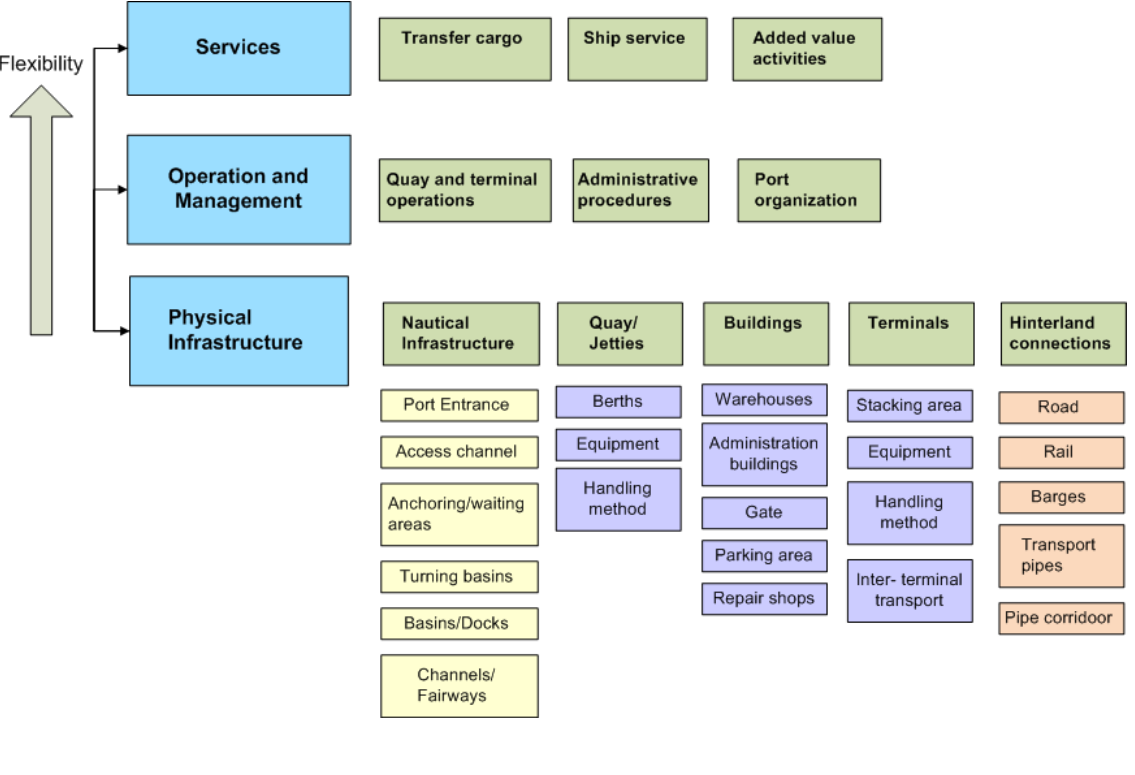
Figure 1. Three-layer inframodel of a